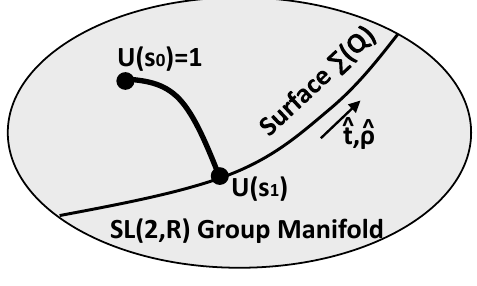
Figure 3 . A sketch of computation of holographic entanglement entropy from the view point of SL(2,R) group manifold. A trajectory of U ( s ) in the SL(2,R) group manifold is depicted as a thick curve with dots at its ends. We impose the initial condition U ( s 0 ) = 1 and the Dirichlet-Neumann boundary condition such that U ( s 1 ) is on Σ Q , which is a codimension one subspace of